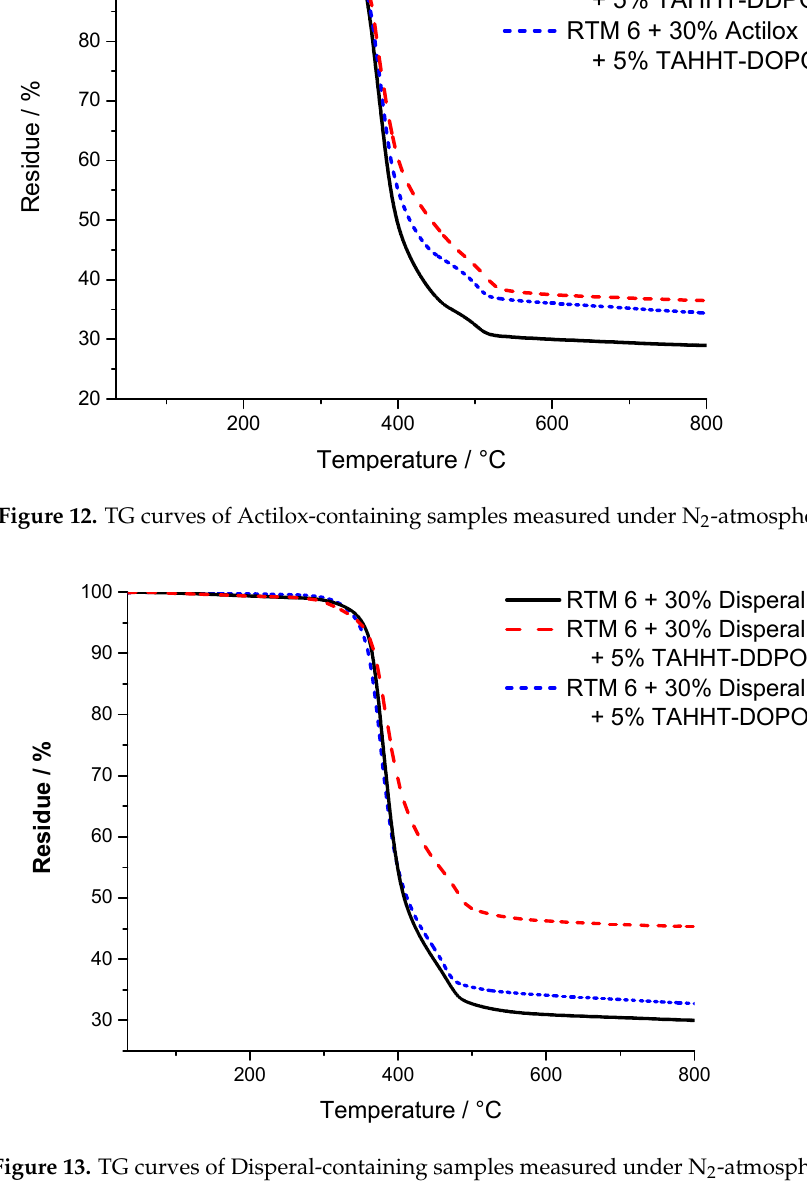
Figure 14. TG curves of Actilox-containing samples measured under air. Figure 15. TG curves of Disperal-containing samples measured under air.